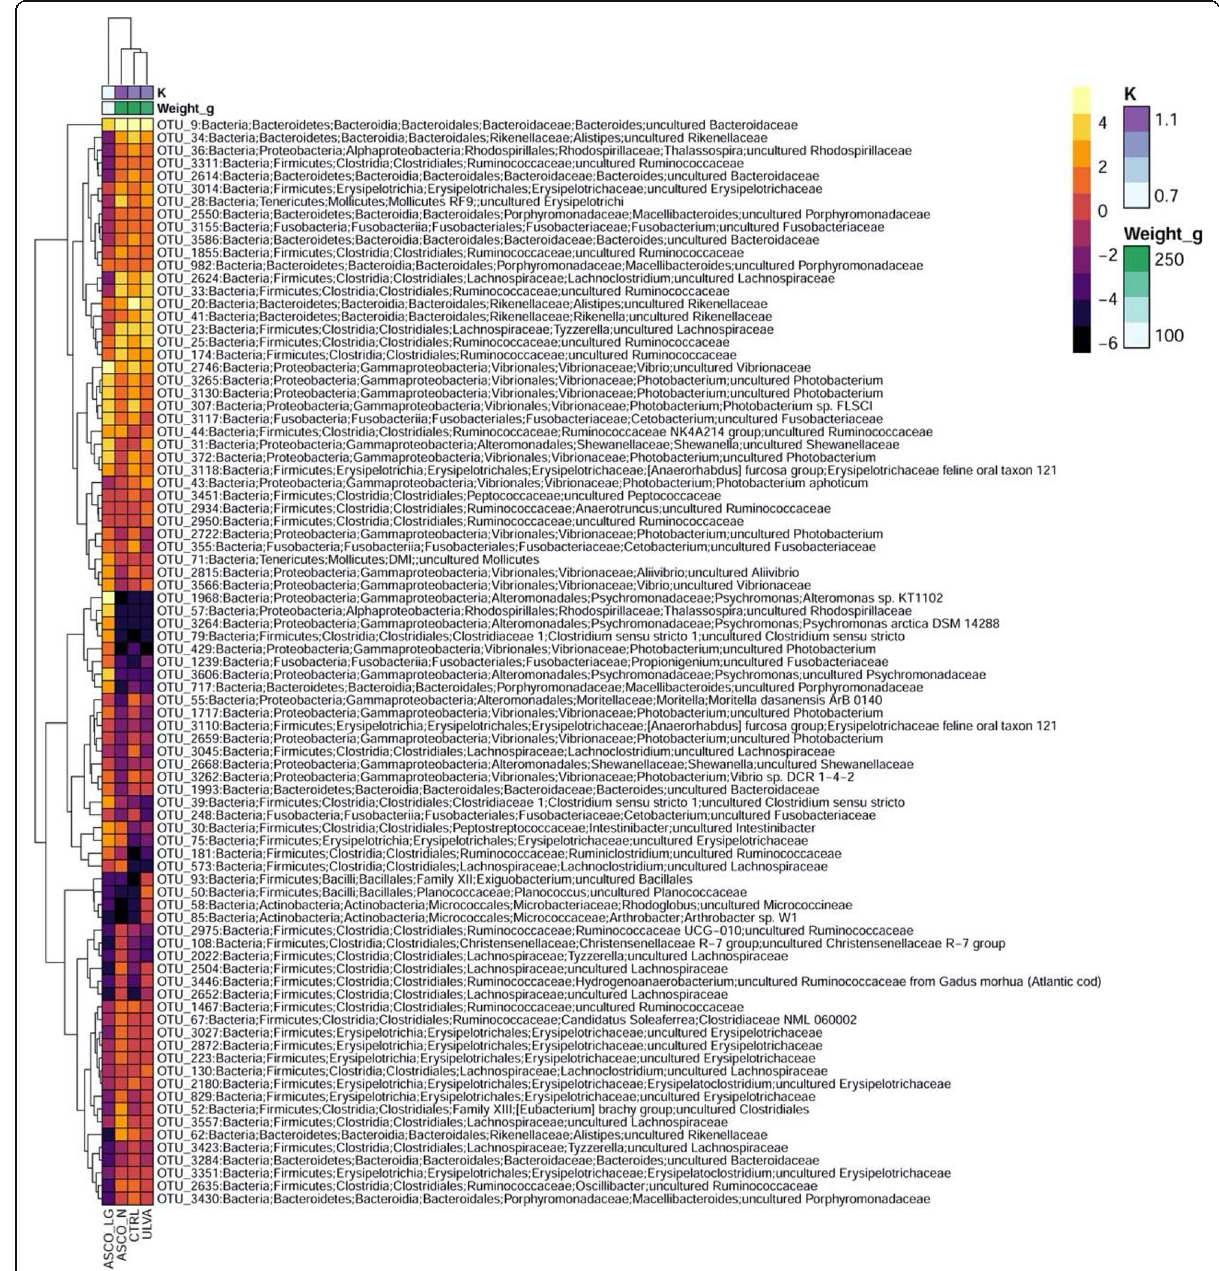
Fig. 6 sPLS-DA heatmap of the discriminant operational taxonomic units (OTUs)> 3.5% relative abundance between the CRTL, ULVA, ASCO_N and ASCO_LG groups of juvenile Atlantic cod ( Gadus morhua ) at Week 12. Rows and columns are ordered using hierarchical (average linkage) clustering to identify blocks of genera of interest. The heatmap depicts TSS + CLR (Total Sum Scaling followed by Centralised Log Ratio) normalised abundances: high abundance (orange/yellow) and low abundance (dark purple). Fish weight (g) and condition factor (K) is shown per grouping. sPLS-DA was fine-tuned using centroids.dist and 3 tuning